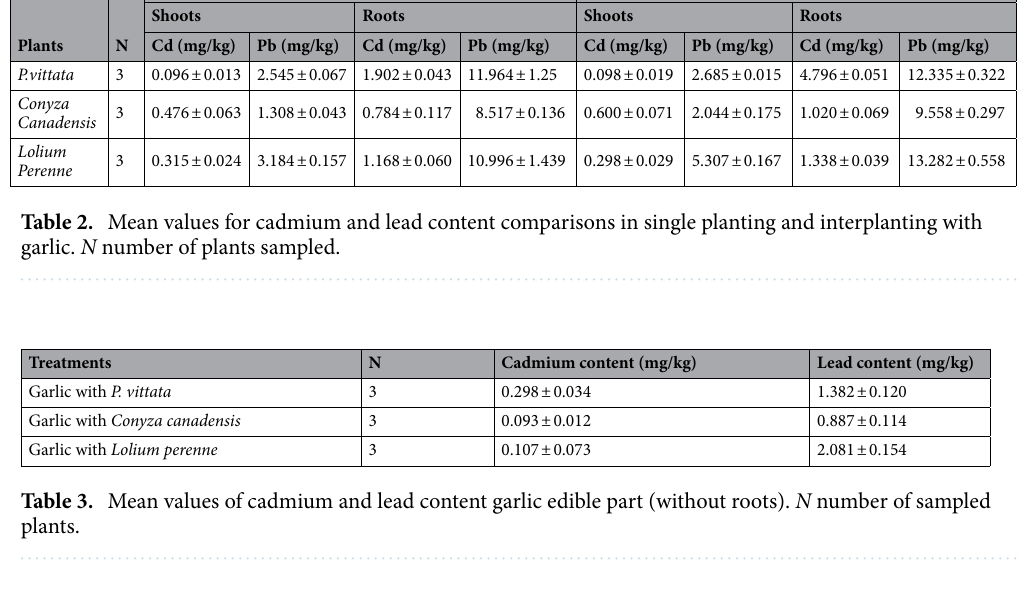
Table 3. Mean values of cadmium and lead content garlic edible part (without roots). N number of sampled plants.